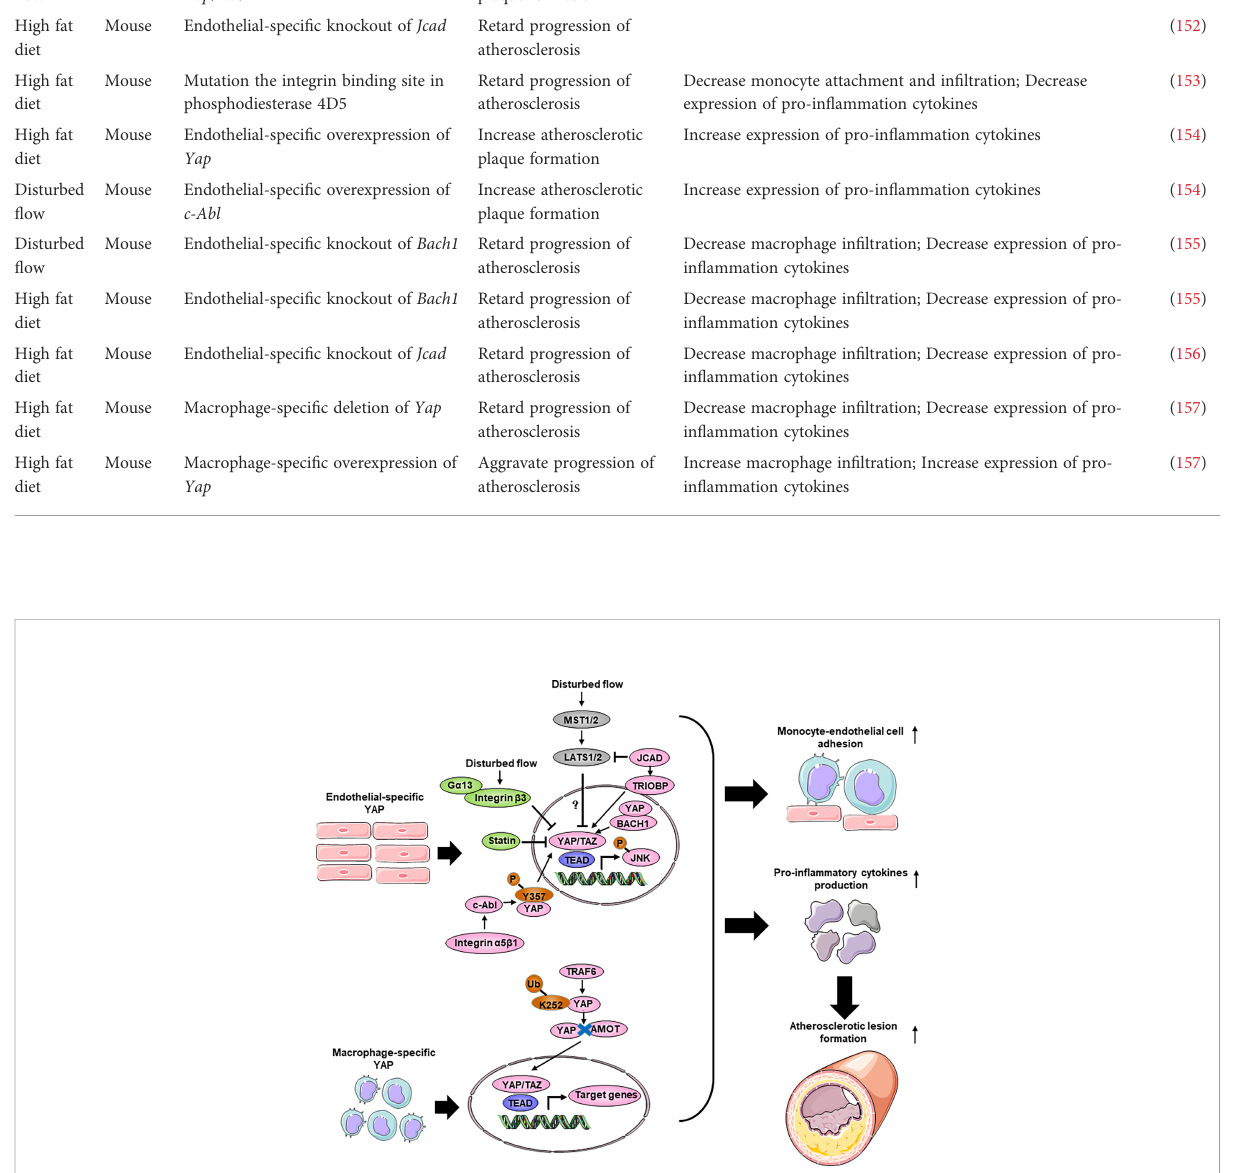
FIGURE 4 The role of Hippo-YAP pathway regulating in fl ammation response during atherosclerosis. Disturbed fl ow promotes YAP nuclear translocation and activates the JNK signaling without affecting the Hippo kinases, thereby accelerates monocyte-endothelial cell adhesion and pro- in fl ammatory cytokines production to increase the formation of atherosclerotic lesion. Several upstream regulators such as JCAD, BACH1, Integrin b 3 and c-Abl affect endothelial in fl ammation and atherosclerosis through interacting with YAP. Moreover, statins exert anti- atherosclerosis function partly through YAP. In bone marrow derived macrophage, YAP undergoes TRAF6-dependent ubiquitination and translocate into nucleus in response to IL-1 b . Macrophage-speci fi c overexpression of YAP promotes macrophage accumulation and pro- in fl ammatory cytokines production, thereby aggravates atherosclerosis. BACH1, BTB domain and CNC homolog 1; G a 13, guanine nucleotide- binding protein subunit alpha 13; JCAD, junctional cadherin 5 associated; TRIOBP, TRIO and F-actin binding protein; TRAF6, TNF Receptor Associated Factor